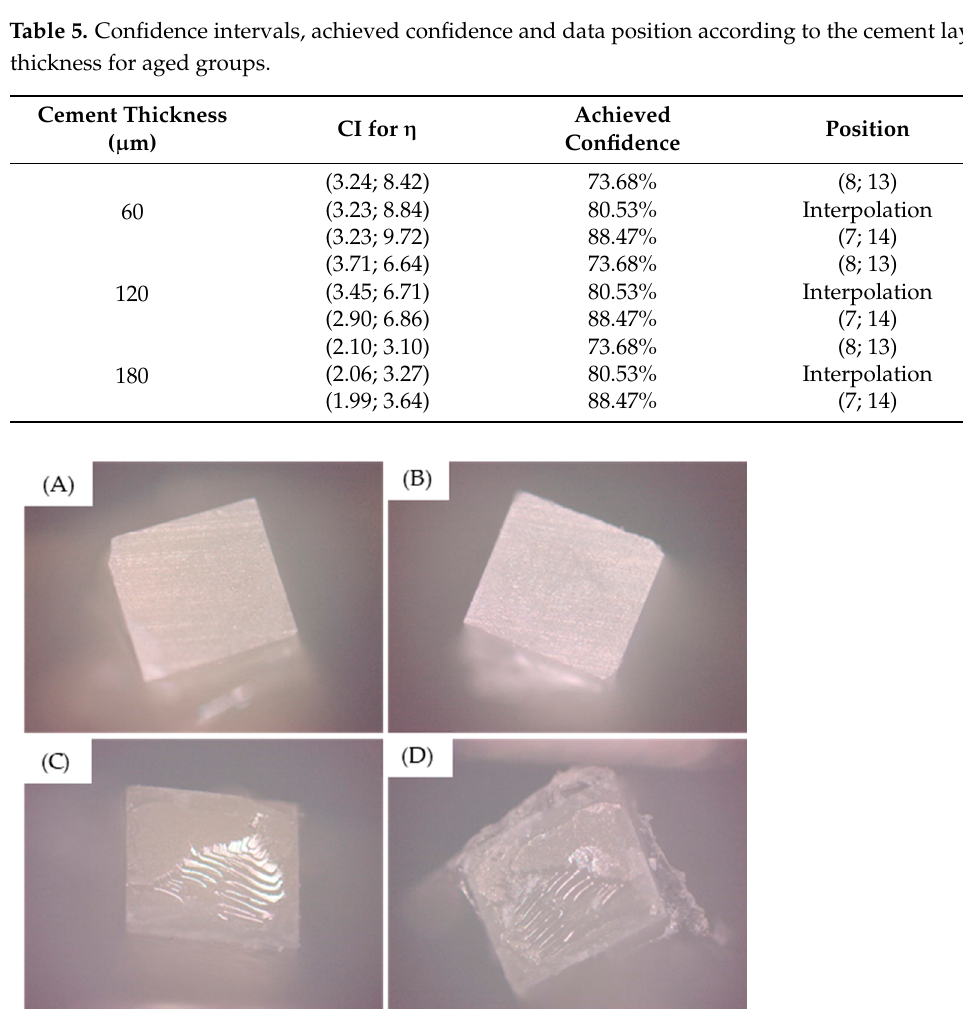
Figure 5. Predominant failure type observed after the testing. ( A , B ) Purely adhesive failures and ( C , D ) mixed failures.